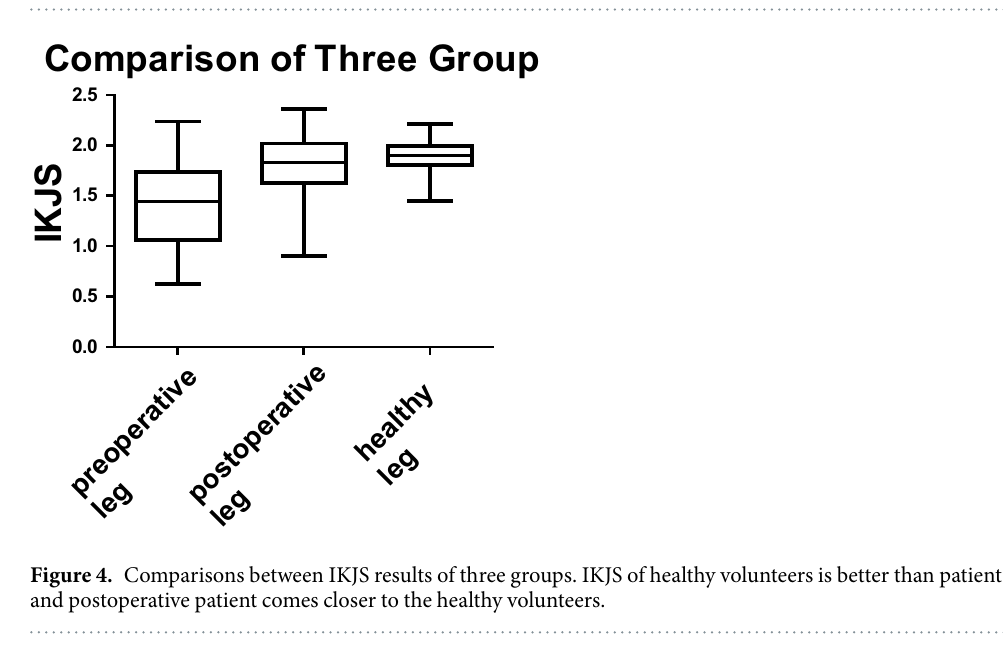
Figure 3. On the 1~30 scale of the MSE, a comparison between three groups. The MSE of displacement time series at scales 12–15 was observed to be different among three groups.